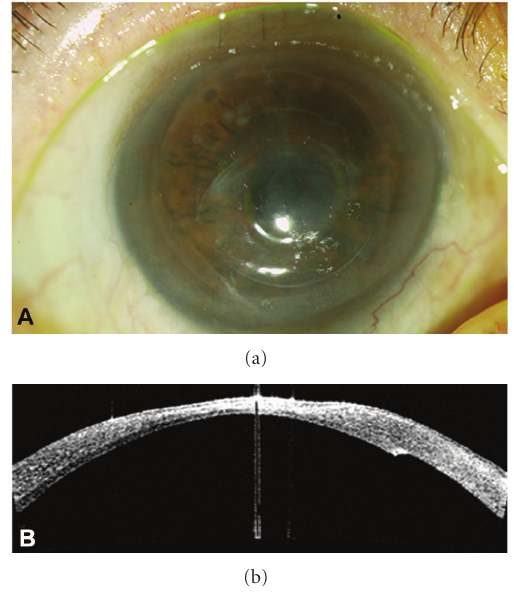
Figure 3: Month 8 postoperatively. (a) Slit lamp photography showing smooth and stable ocular surface, no epithelial defect, and mild stromal thinning. (b) Visante OCT showing a totally adhered posterior lenticule, a structurally stable cornea with a mild stromal